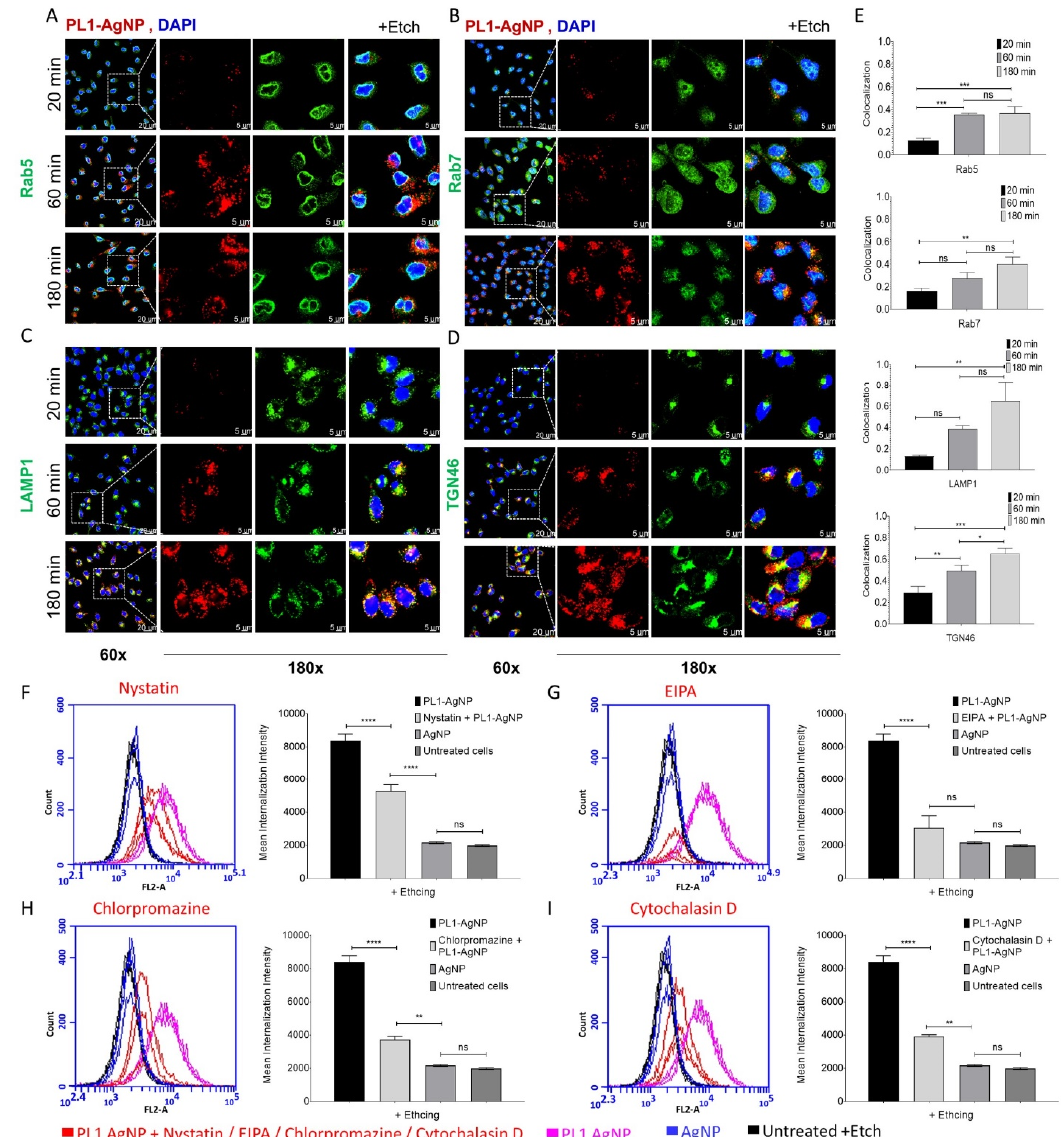
Figure 5. Colocalization of PL1-functionalized silver nanoparticles (AgNPs) with endocytic markers, and inhibition of endocytosis pathways in U87-MG cells. Confocal microscopy images of U87-MG attached cells incubated with PL1-AgNPs (red) at 20, 60, and 180 min time points, and cells were treated by etching solution to visualize only internalized particles. The cells were stained with ( A ) early endosome marker Rab 5A (green); ( B ) late endosome marker Rab 7A (green); ( C ) lysosome marker LAMP-1 (CD107a; green); and ( D ) trans-Golgi network marker TGN46 (green). The cells were counterstained with DAPI (blue). Scale bar: 20 µm (60×), for the magnified images 5 µm (180×). ( E ) The relative colocalization was assessed with Manders coefficient (M2) using ImageJ software and shown in the bar chart. Internalized PL1-AgNP colocalization with markers was quantified from representative images using a one-way ANOVA test. Error bars: mean ± SD ( n = 3, three independent experiments), ns p > 0.05, * p < 0.05, ** p < 0.01, *** p < 0.001, **** p < 0.0001. For the FACS analysis, U87-MG cells were pre-incubated with inhibitors of endocytic pathways, 50 µM Nystatin ( F ), 1 mM 5-(N-ethyl-N-isopropyl)-Amiloride (EIPA) ( G ); 10 µ M Chlorpromazine ( H ); 4 µ M Cytochalasin D ( I ); and untreated cells as control, and AgNPs for 30 min. The cells were incubated with PL1-AgNPs for 60 min, and cells were treated by etching to remove membrane-bound particles. The cells were analyzed with flow cytometry for inhibition of uptake. CF555-gated plot showing cell internalization and inhibition of PL1-AgNPs (pink: internalization; red: inhibition) compared to control particles AgNP (blue). The cells without AgNPs were included as a control standard (black). The BD Accuri C6 software was used for the quantification of cell mean intensity from three independent experiments. The bar chart showing one-way ANOVA test, Error bars: mean ± SD (N: 1000 cells/experiment), ns p > 0.05, * p < 0.05, ** p < 0.01, *** p < 0.001, **** p <